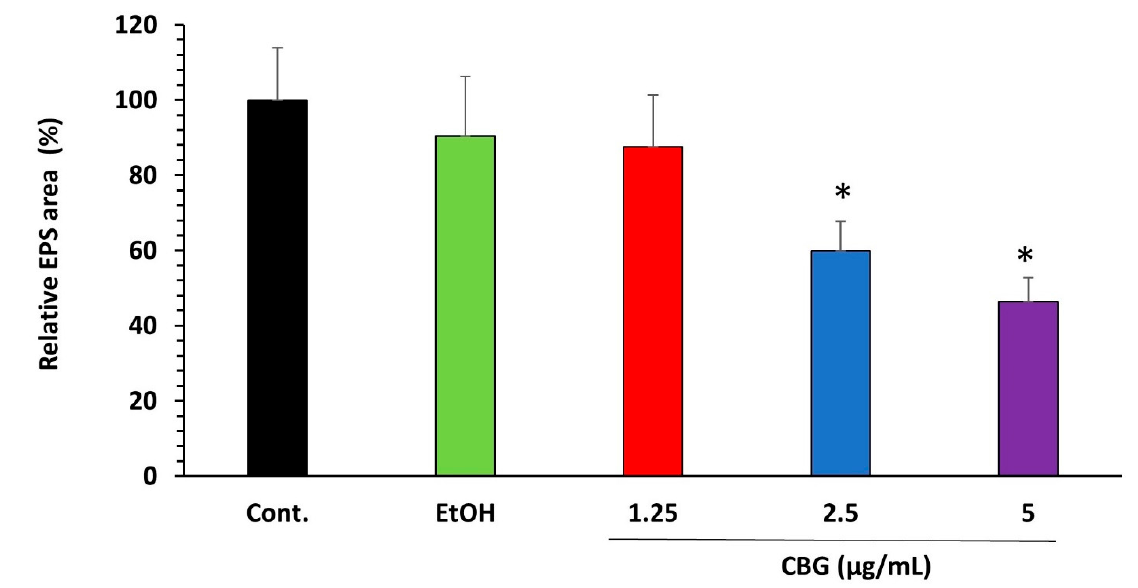
Figure 4. CBG decreases EPS production in S. mutans biofilm. Congo red matrix staining of S. mutans biofilms formed for